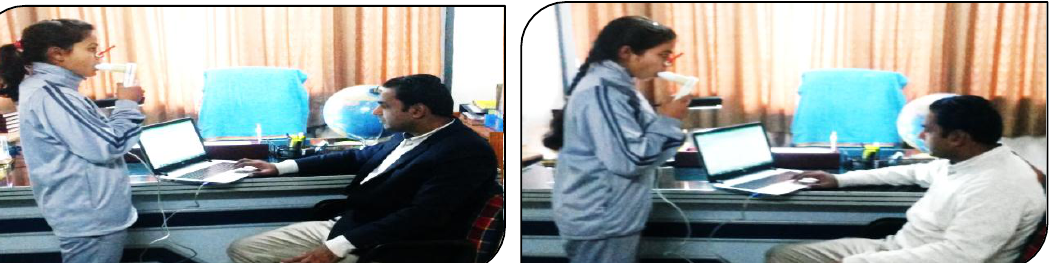
Fig. 6. Subjects Performing Inspiratory Capacity (IC) Experimental Treatment